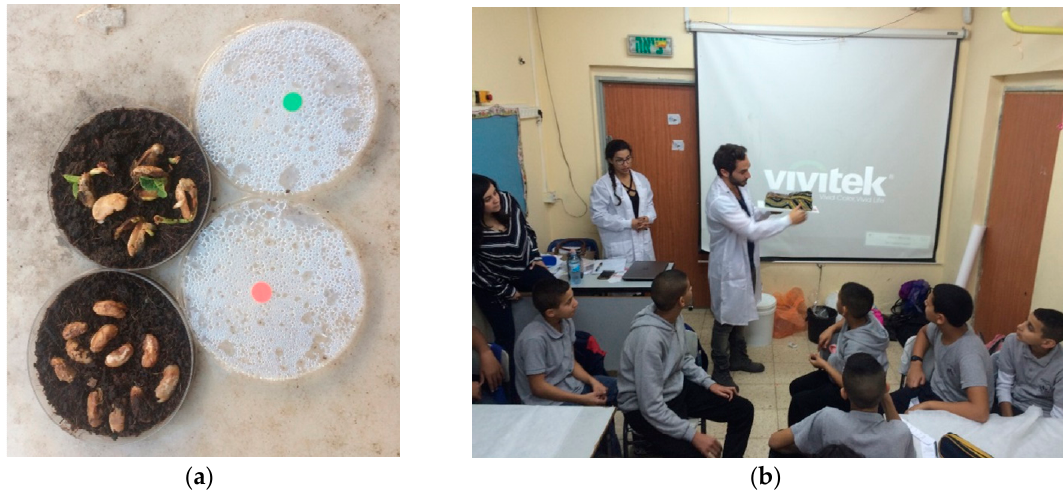
Figure 3. ( a ) An experiment the “soil pollution group” was asked to carry out at home sprouting beans on a fruitful ground as opposed to a contaminated soil; ( b ) Explains the pupils the layered structure of the soil with the help of a sample.